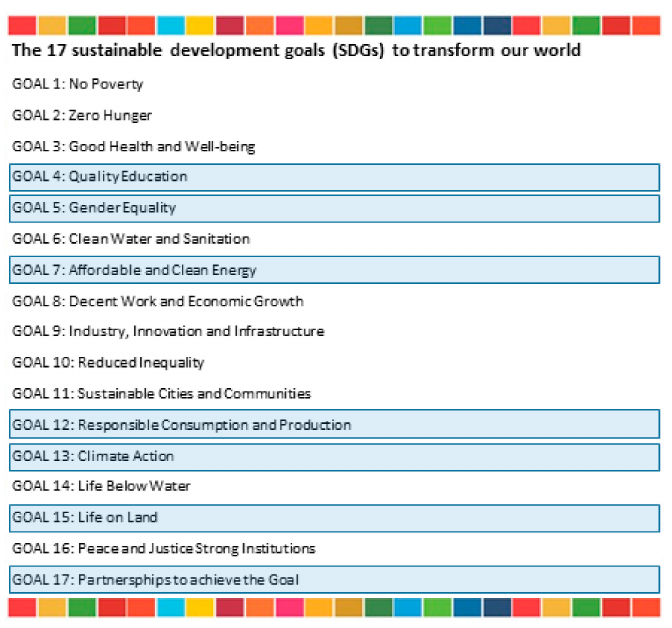
Figure 1. The 17 Sustainable Development Goals. The focused goals of our concept are framed